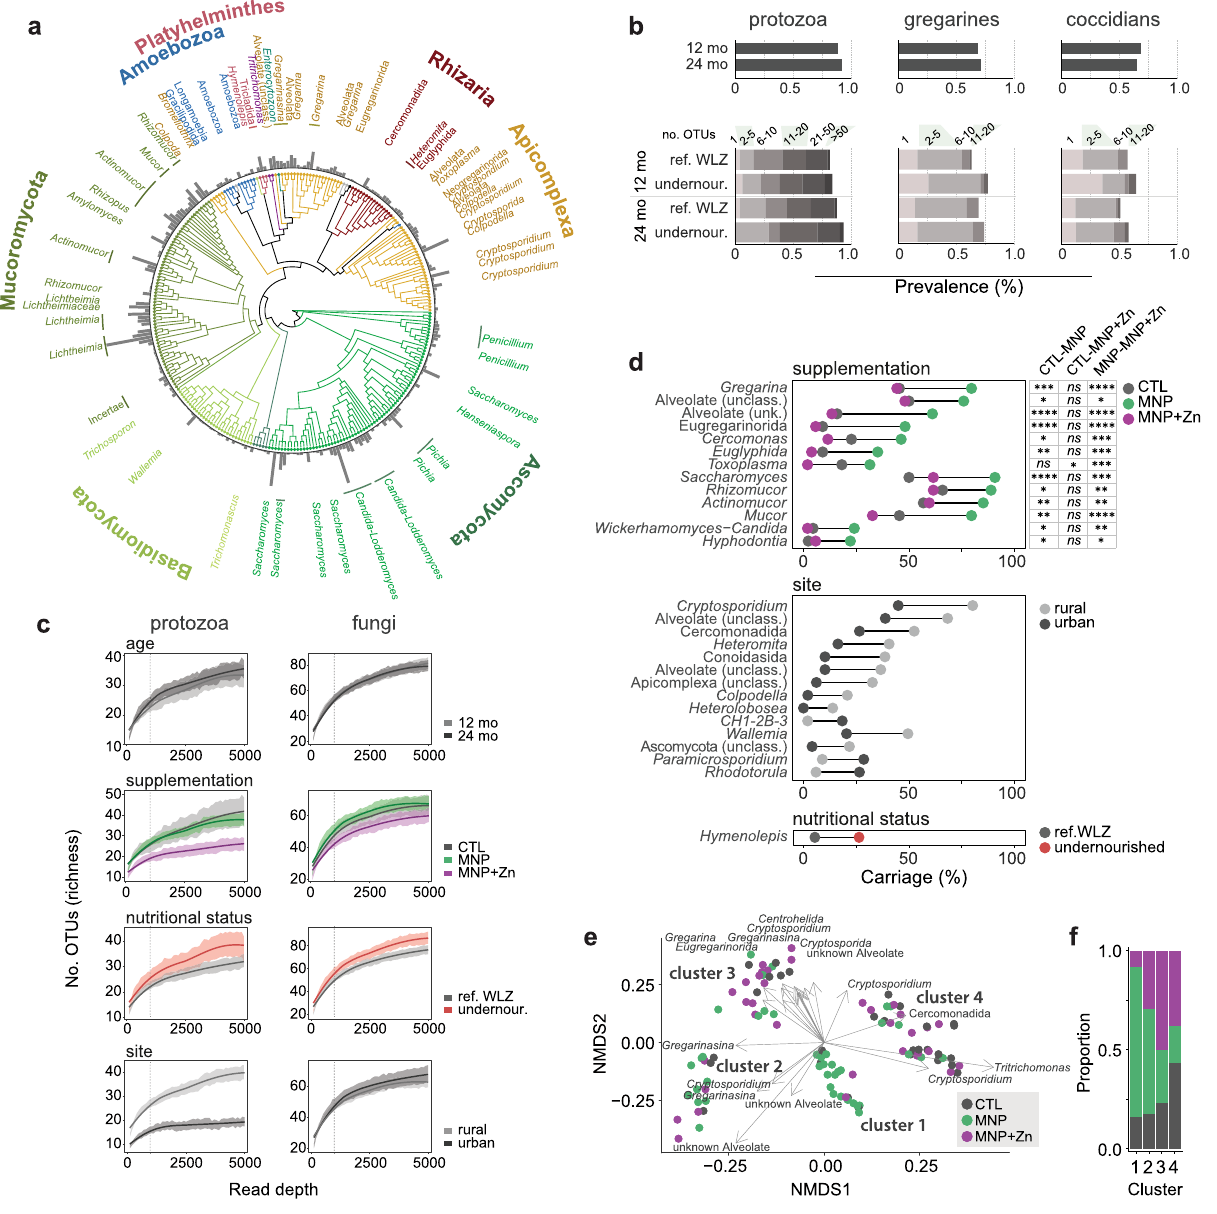
Fig. 2 Eukaryotic communities in the gut are diverse and impacted by micronutrient supplementation and place of residence. a Phylogenetic tree representing eukaryotic taxa detected in children. Branches are colored by phylum, and bars represent the prevalences of OTUs in the cohort. Named organisms represent those detected in more than 5% of samples with a minimum of 100 reads. b Prevalences of protozoan (left), and speci fi cally gregarine (middle) or coccidian (right) OTUs detected in children at 12 and 24months of age. Prevalences are subdivided by nutritional group in bottom graphs, where shaded regions denote binned numbers of OTUs identi fi ed per sample. c Rarefaction curves comparing the mean protozoan and fungal species richness by age group, micronutrient supplementation, nutritional status, and place of residence (site). Shaded regions represent standard error. Dashed lines denote the read depth at which signi fi cance was tested. d Carriage of eukaryotic taxa signi fi cantly associated with micronutrient supplementation, place of residence (site), or nutritional status ( n = 150). Signi fi cant pairwise differences among supplementation groups are indicated to the right (* p <0.05, ** p <0.01, ** *p <0.001, **** p <0.0001, ns no signi fi cant difference) based on two-sided pairwise Fisher ’ s Exact tests and corrected for multiple testing using the Benjamini – Hochberg method. Exact p -values are provided in Supplementary Data 3. e Non-metric multidimensional scaling of sample dissimilarities ( n = 105) based on protozoan composition, calculated using unweighted UniFrac scores. Samples are colored by the supplementation arm, and arrows indicate the direction of increasing carriage of taxa signi fi cantly correlated with the fi rst two ordination axes. Arrow lengths are scaled by the root square ( r 2 ) of the correlation. Identi fi ed clusters are numbered 1 through 4. f Proportions of samples from the respective supplementation arms within each protozoan community Cryptosporida (coccidians), represented by 46 OTUs in total, in control and MNP arms (GLM, β = − 15.19, 95% CI [ − 29.27, − 1.12], p < 0.05), suggesting a possible inhibitory effect by the undernourished children (74% versus 65% at 12 months, ns ; 71% versus 61% at 24 months, ns ; Fig. 2b). Furthermore, under- metal (Fig. 2c, Supplementary Fig. 3). nourished children receiving MNPs with zinc had signi fi cantly We next compared the phylogenetic compositions of proto- fewer protozoan OTUs relative to undernourished children in the zoan and fungal populations. The fungal composition was not